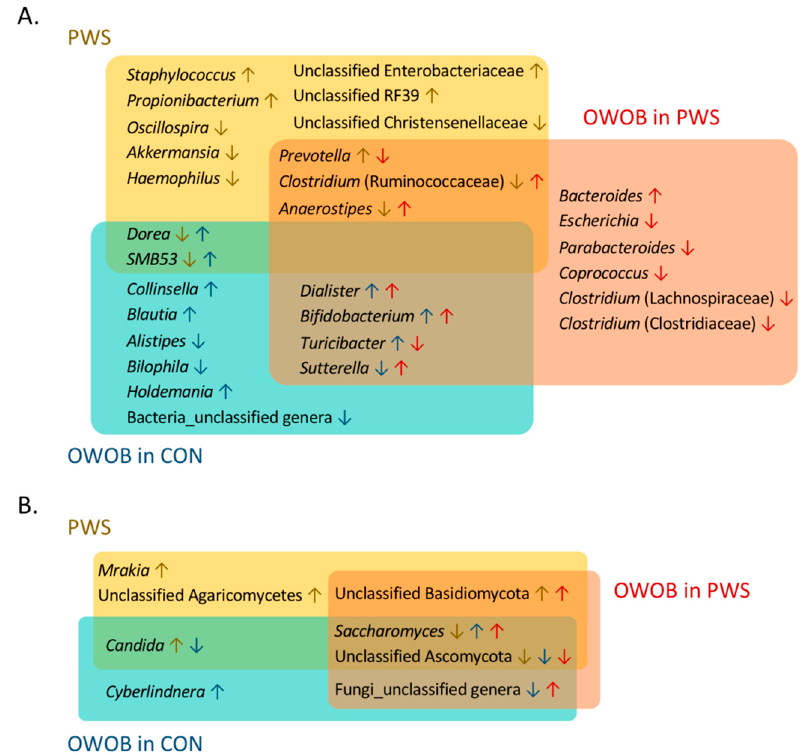
Figure 3. Overlap of differentially abundant bacterial ( A ) and fungal ( B ) taxa detected in Random Forest models for the PWS, OWOB PWS, and OWOB CON groups. PWS: Prader–Willi syndrome; CON: control; NW: normal weight; OWOB: overweight or obese. Upwards arrows indicate higher abundance, whereas downwards arrows indicate lower abundance than the reference group(s) (PWS vs. CON; OWOB in CON vs. NW in CON; OWOB in PWS vs. NW in CON).